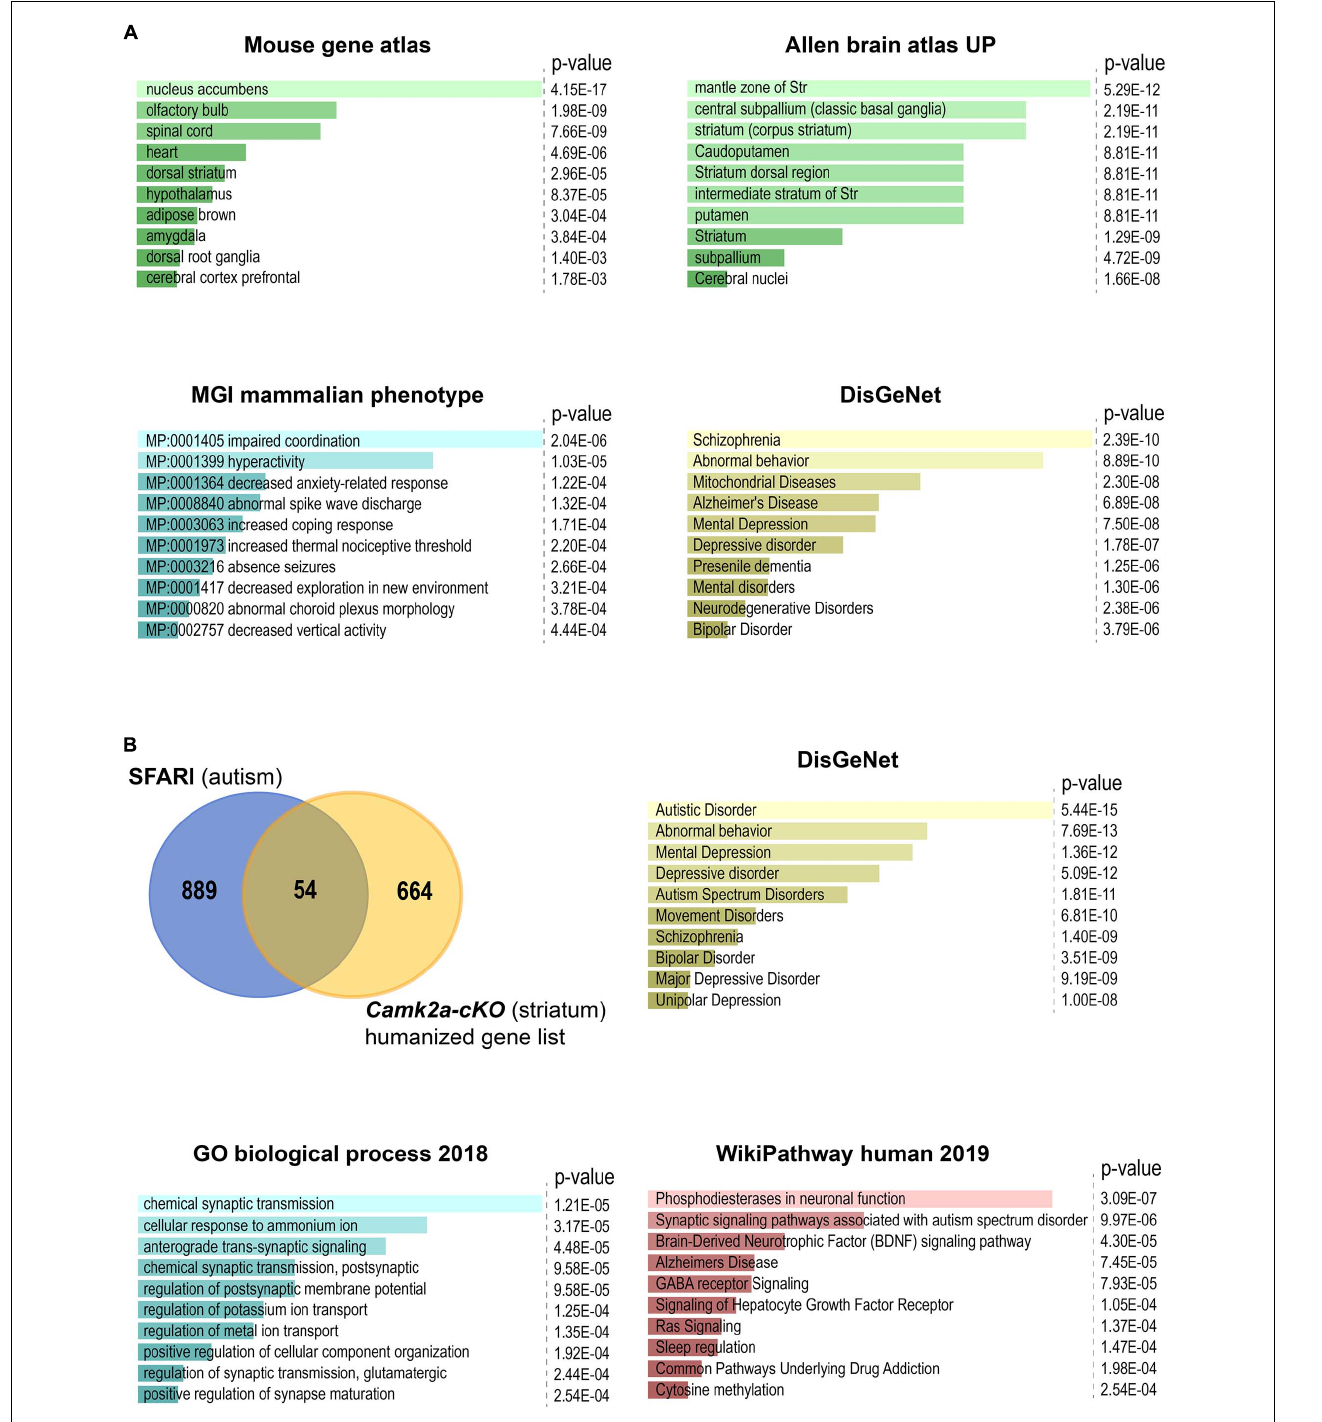
FIGURE 4 | Enrichment analysis using EnrichR of DEGs between Camk2a-cKO and control. The bar plots show the top 10 terms selected according to their P -value. All enrichment results are also shown in Supplementary Tables 2 , 3 . (A) Analysis of all the DEGs. Highest-scoring is found for: nucleus accumbens, which is part of the ventral striatum, in the mouse gene atlas; terms related to striatum in the Allen brain atlas UP category; impaired coordination, which is commonly associated with ASD, in the MGI mammalian phenotype database; neurological disorders in the crowd-based DisGeNet. (B) Analysis of the 54 genes overlapping between the SFARI gene list and human orthologs of our list of DEGs. Highest scoring is found: in DisGeNet for autistic disorder (to note the strong overlap between these terms and those issued from the DisGeNet analysis of the overall set of DEGs); in Gene Ontology Biological Process for terms related to synaptic transmission and membrane potential; in human WikiPathways, for terms related to synaptic signaling pathways, including pathways associated with ASD.